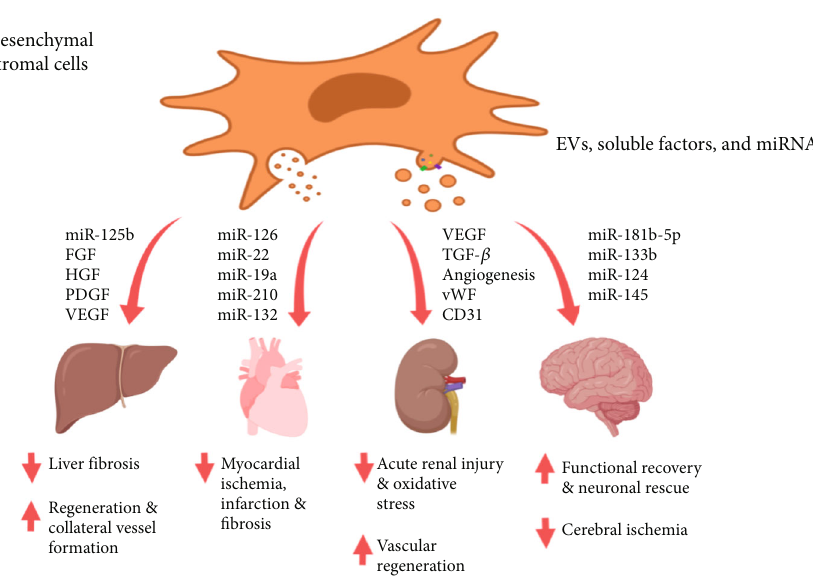
Figure 3: Schematic representation of the secretome e ff ects on major organs in vivo . EVs, soluble factors, proteins, and miRNAs present in the MSC secretome are in favor of regeneration, reperfusion, and recovery of major organs and tissues following trauma and ischemic